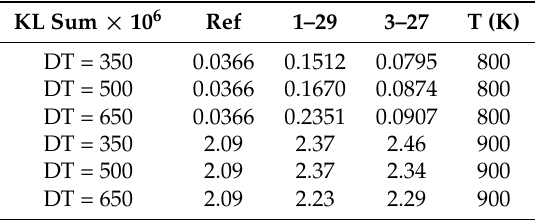
Table 4. Summary of KL sum in the first stages for pilot-main strategies for a rail pressure of 100 MPa, a chamber density of 22.8 kg · m − 3 and temperature of 900 K and 800 K when pulses decoupled. The mass flow pulses [13] are plotted.